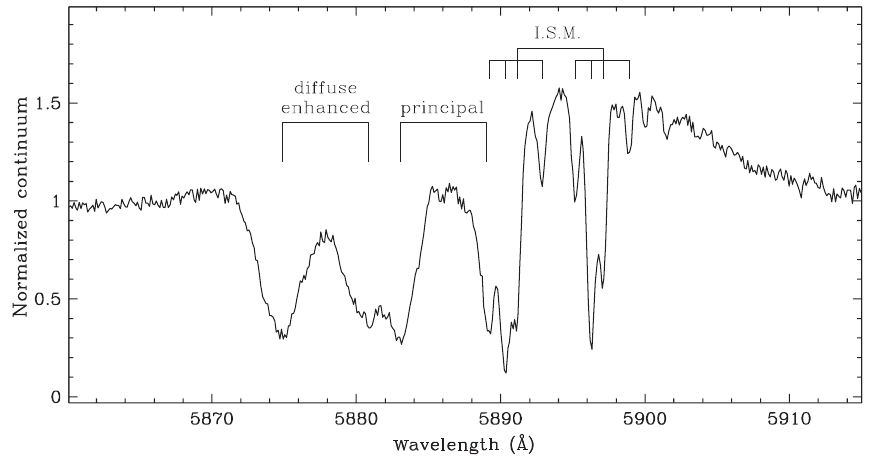
Fig. 3. The complex Na I D 1 ; 2 region for Nova Sct 2009 as recorded on an ANS Echelle high resolution spectrum on 2009 November 21, two days after the optical maximum and when the star was at V = 7.6. The resolving power is 17 000. At least four distinct interstellar components and both the principal and diffuse enhanced spectra of the nova are visible at the same